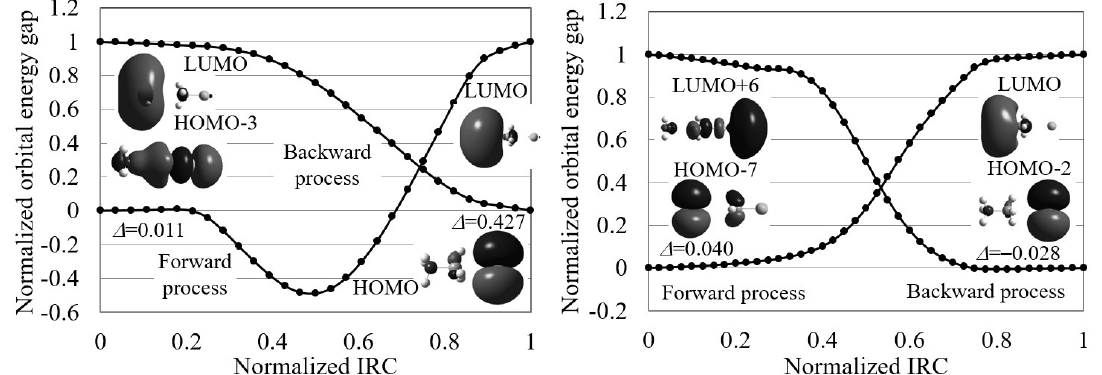
Figure 6. The normalized reaction diagrams of the three steps of the Menschutkin reaction (NH 3 + CH 3 Cl → NH 3 CH + + Cl − ) in gas phase and in aqueous solution, which are calculated by 3 LC-BLYP/aug-cc-pVTZ. The images of the molecular orbitals mainly contributing to each reaction process and the calculated orbital energy gap gradient values are also shown.